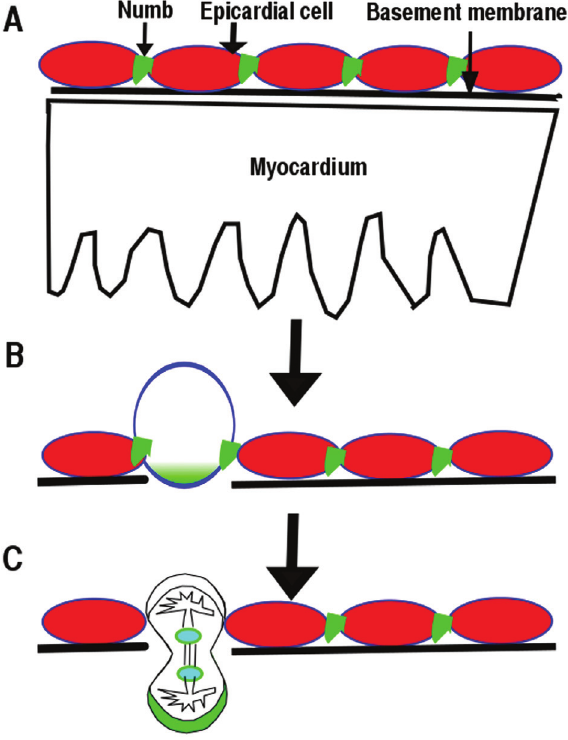
Figure 3: Epicardial cells’ perpendicular division contributes to their entry into